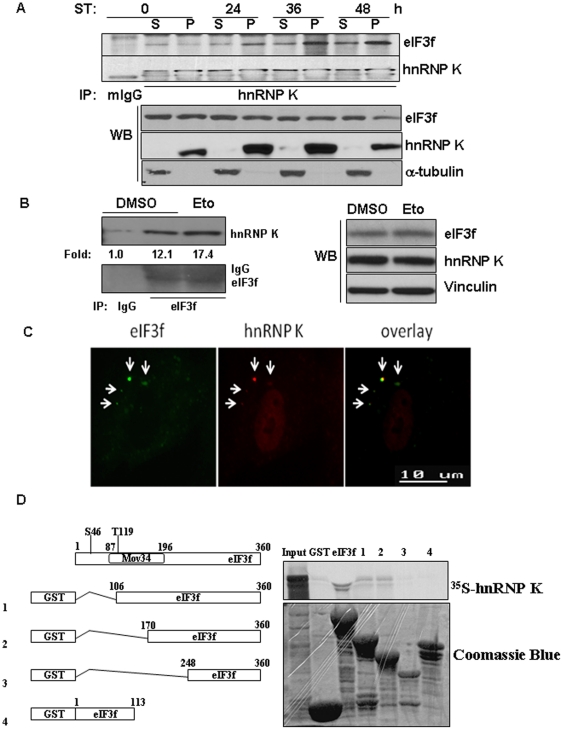
Increased endogenous interaction between eIF3f and hnRNP K under stress.(A) A375 cells were treated with staurosporine (ST) for the indicated time and cell fractionation was performed as previously described [17]. 500 µg of the lysates from the soluble (S) and pellet (P) fractions of the cells were immunoprecipitated with IgG or hnRNP K antibodies, followed by immunoblot with eIF3f and hnRNP K antibodies (top 2 panels). 50 µg of the same lysates were used for immunoblot with eIF3f, hnRNP K and α-tubulin antibodies without immunoprecipitation (bottom 3 panels). (B) HPDE cells were treated with DMSO or etoposide (Eto) (10 µM) for 24 hours. Cell lysates were immunoprecipitated with IgG or eIF3f antibodies, followed by immunoblot with eIF3f and hnRNP K antibodies (left 2 panels). The intensities of the bands were quantified using ImageJ software. The same cell lysates were used for immunoblot with eIF3f, hnRNP K and vinculin antibodies without immunoprecipitaiton (right 3 panels). (C) Immunofluorescent staining to eIF3f (FITC, green) and hnRNP K (Cy3, red) in HFF-1 fibroblasts treated with sodium arsenite (0.5 mM) for 30 minutes. (D) eIF3f directly interacted with hnRNP K. The left diagram shows full-length eIF3f and the location of the Mov34/JAB_MPN domain. Four GST-eIF3f truncation mutants were designed to localize the binding site of eIF3f with hnRNP K. GST pull-down assay was performed as described in the Materials and Methods.